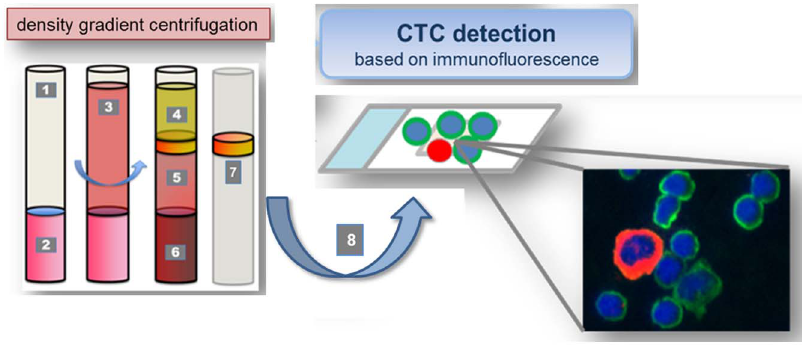
Figure 1. Basic principle of CTC isolation. 1. Leucosep tube: 2. Separation media; 3. Whole blood/PBMNC mixture; 4. Plasma; 5. Separation media after centrifugation; 6. Erythocytes; 7. Buffy coat incl. CTCs; Cell suspension containing CTCs for Cellspin and multi-immunofluorescence staining. Before and after curative resection, mononuclear cells and CTC were isolated from peripheral venous blood using density gradient centrifugation. Cell suspensions were carefully spun onto glass slides. The presence of CTC was verified by immunofluorescence staining against pan-CK (epithelial), N-cadherin (mesenchymal), CD133 (stemcell-like); counterstaining with CD45 (hematopoietic) and DAPI (nucleus). CTC and hematopoietic cells were enumerated, normalized and individual cell type profiles were analyzed and correlated to therapeutic outcome in 10